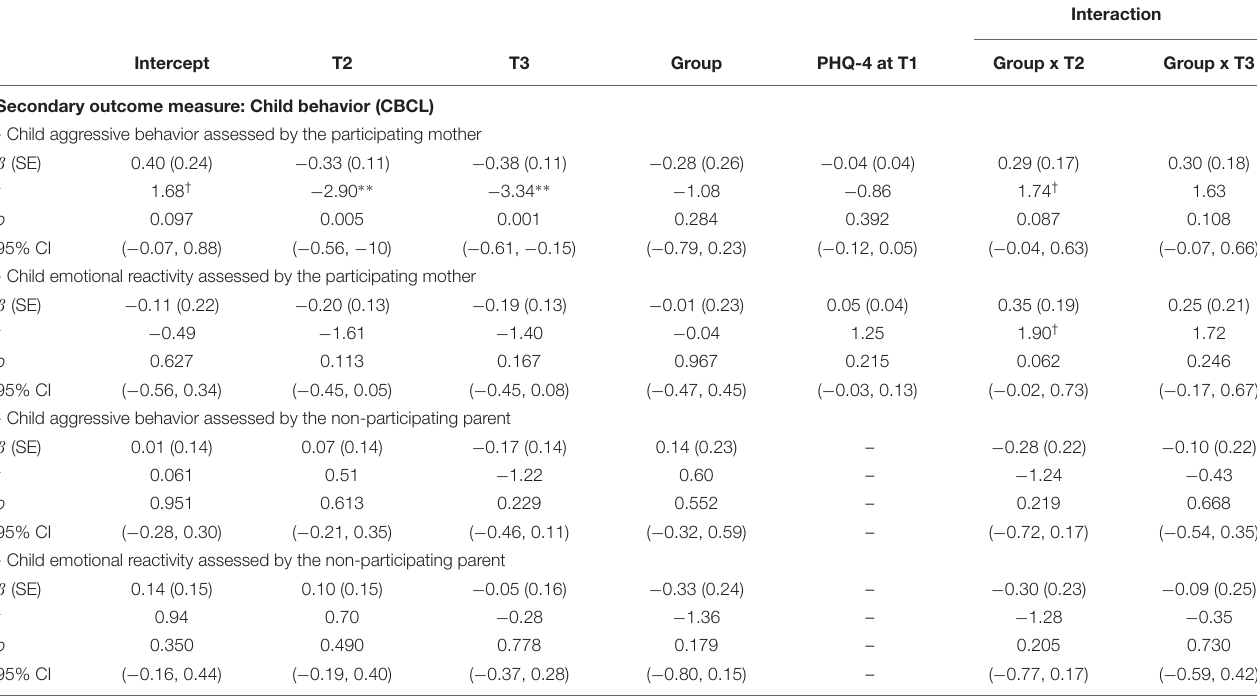
TABLE 8 | Secondary outcome measures (child behavior): Standardized parameter estimates (and standard errors), t and p values, and 95% confidence intervals of multilevel models of intervention outcome predicted by measurement point (T2 and T3, deviations from T1), group [intervention (reference) and waitlist control group], control variable (PHQ-4 score at T1), and interaction variables (group by T2 and